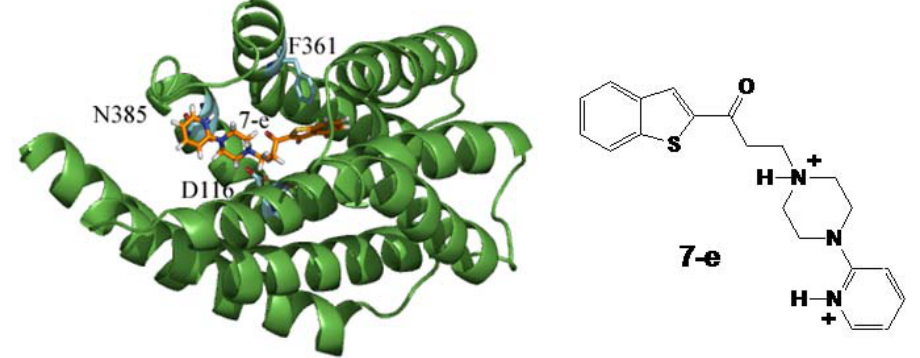
Figure 3. Compound 7e docked to 5-HT with compound 7e are shown in bold